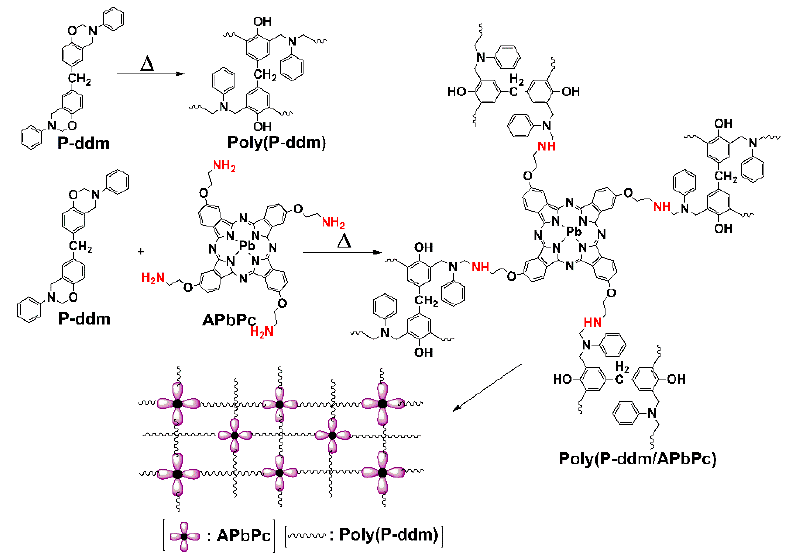
Figure 1. FTIR spectra of neat phenol-diaminodiphenylmethane-based benzoxazine (P-ddm) resin, P-ddm/APbPc (3,10,17,24-tetra-aminoethoxy lead phthalocyanine) blend, and P-ddm/APbPc copolymer. ( A ) 2000–4000 cm − 1 , ( B ) 600–2000 cm − 1 .